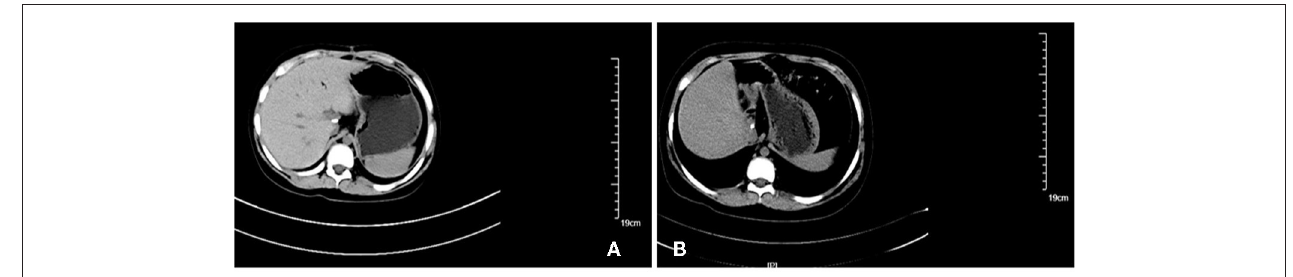
FIGURE 3 | Imaging findings during follow up: there was no abnormal density shadow in the liver, which was consistent with the changes of hepatic caudate lobe resection. (A) abdominal computed tomography of the abdomen 2 months after the surgery; (B) Enhanced computed tomography of the abdomen 14 months after the surgery.